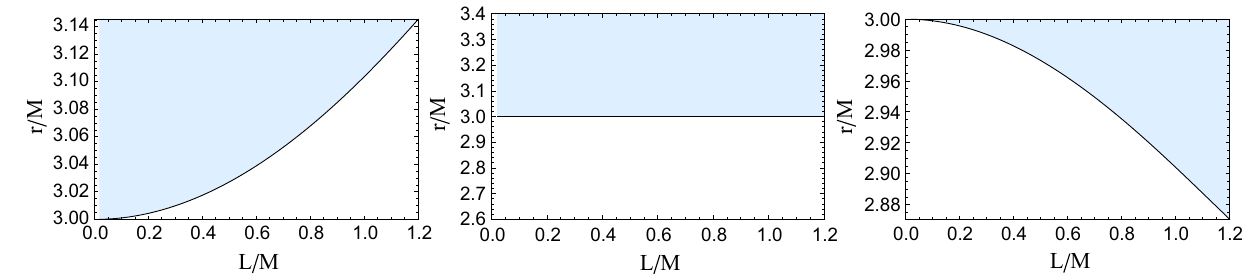
Fig. 6 Plot showing ρ ≥ 0 ( shaded ) region in the non-singular non-rotating black hole spacetime in conformal gravity. The boundary of the white and blue regions ( solid black curve ) represents r ∗ . Here the left , middle , and right panels are for N = 1, N = 2, and N = 3, 2